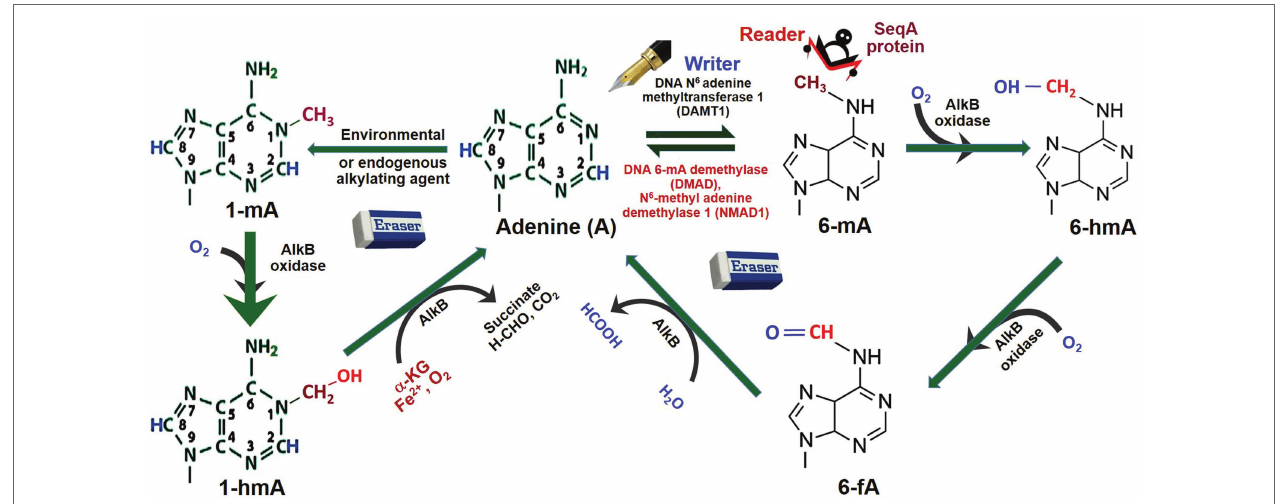
FIGURE 3 | Dynamics of adenine methylation. Adenine (A) gets methylated by the addition of CH 3 (methyl) group at N 6 position by DNA adenine methyltransferases 1, the writer, generating N 6 -methyladenine (6-mA). SeqA protein, the reader, specifically binds to hemimethylated 6-mA DNA. The 6-mA gets hydroxylated (–OH) by AlkB oxidase to N 6 -hydroxymethylcytosine (6-hmA). Due to the erasers like DNA 6-mA demethylase (DMAD) or N 6 -methyladenine demethylase-1 (NMAD1), 6-mA gets deaminated back to Adenine. 6-hmA gets demethylated indirectly to Adenine by AlkB oxidase via N 6 -hydroxymethyl adenine (6-hmA) and N 6 -formyladenine (6-fA). Adenine may also get methyl adduct to N 1 -methyladenine (1-mA) by environmental/endogenous alkylating agents. Similarly, 1-mA may also get demethylated indirectly by AlkB oxidase to Adenine via N 1 -hydroxymethyl adenine (1-hmA). AlkB is one of the prototypic oxidative dealkylation DNA repair enzymes/dioxygenases involved in the removal of alkyl adducts from DNA base by oxidative dealkylation (Redrawn from Kumar et al.,